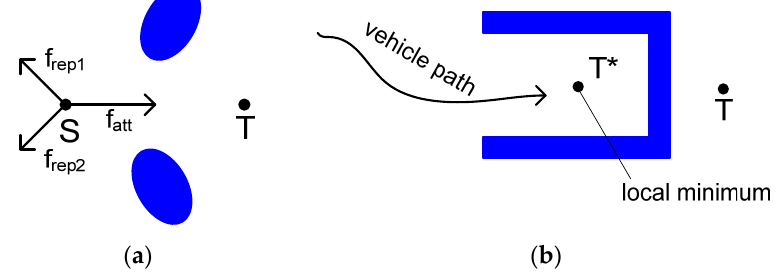
Figure 6. Examples of obstacles moving according to potential field algorithms and stopping before reaching the target point: sum of repulsive vectors balances attraction vector and vehicle stops ( a ); obstacle geometry forces move to local minimum and stop at local target point T* ( b